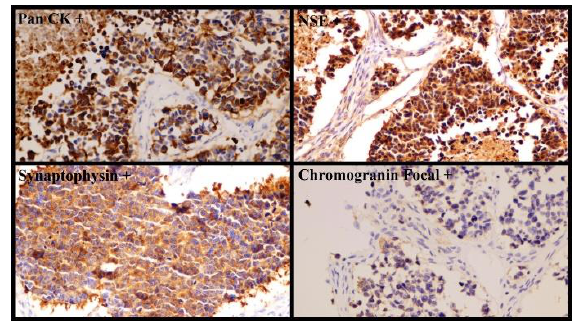
Fig 3. Immunohistochemically profile of tumor cells: Pan CK, NSE;synaptophysin: strongly positive; chromogranin: focally positive Tumor cells were negative for inhibin, TTF-1, and CD99. On the basis of histopathological and